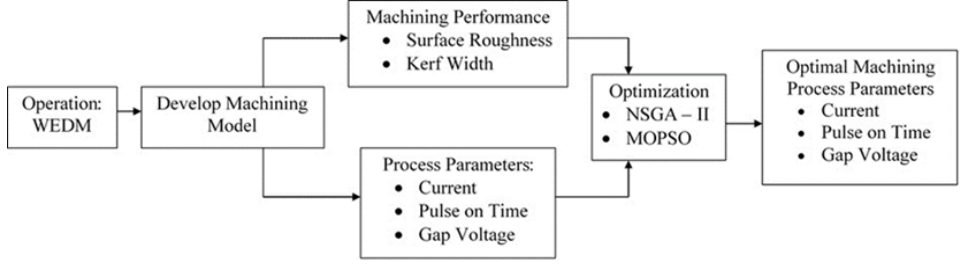
Figure 1. An approach to machining process optimization.